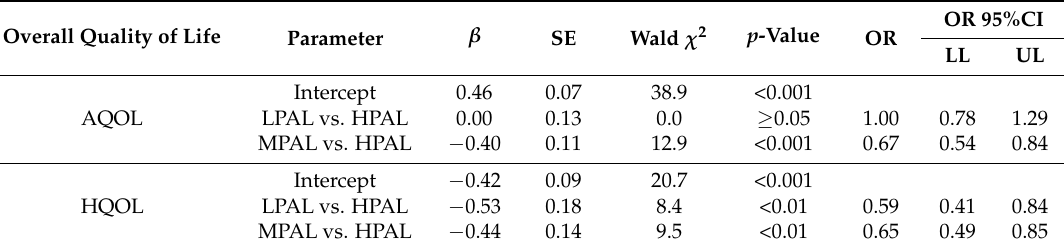
Table 4. Multinomial logistic regression analysis parameters of the dependent variable: overall quality of life in studied men.